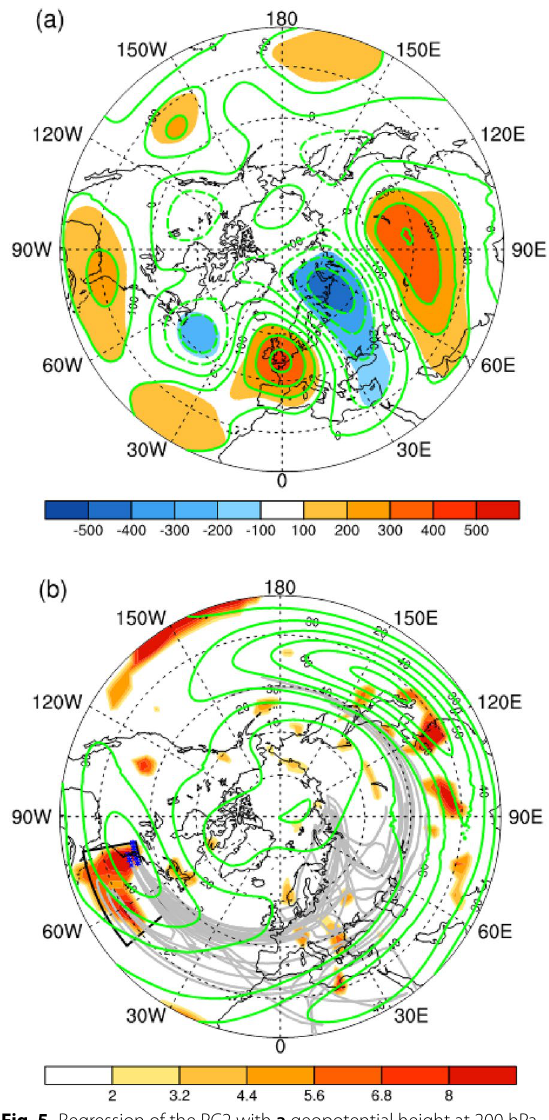
Fig. 5 Regression of the PC2 with a geopotential height at 200 hPa (contours; m) and b Rossby wave source (s − 2 ) during April from 1979 to 2022. The significant results are marked in a . The green contours in b represent the mean zonal winds at 200 hPa during April from 1979 to 2022, and the gray contours are Rossby wave trajectories along the wave pathways (the initial positions are marked). The black box marks the region from 25°N to 40°N and from 80°W to